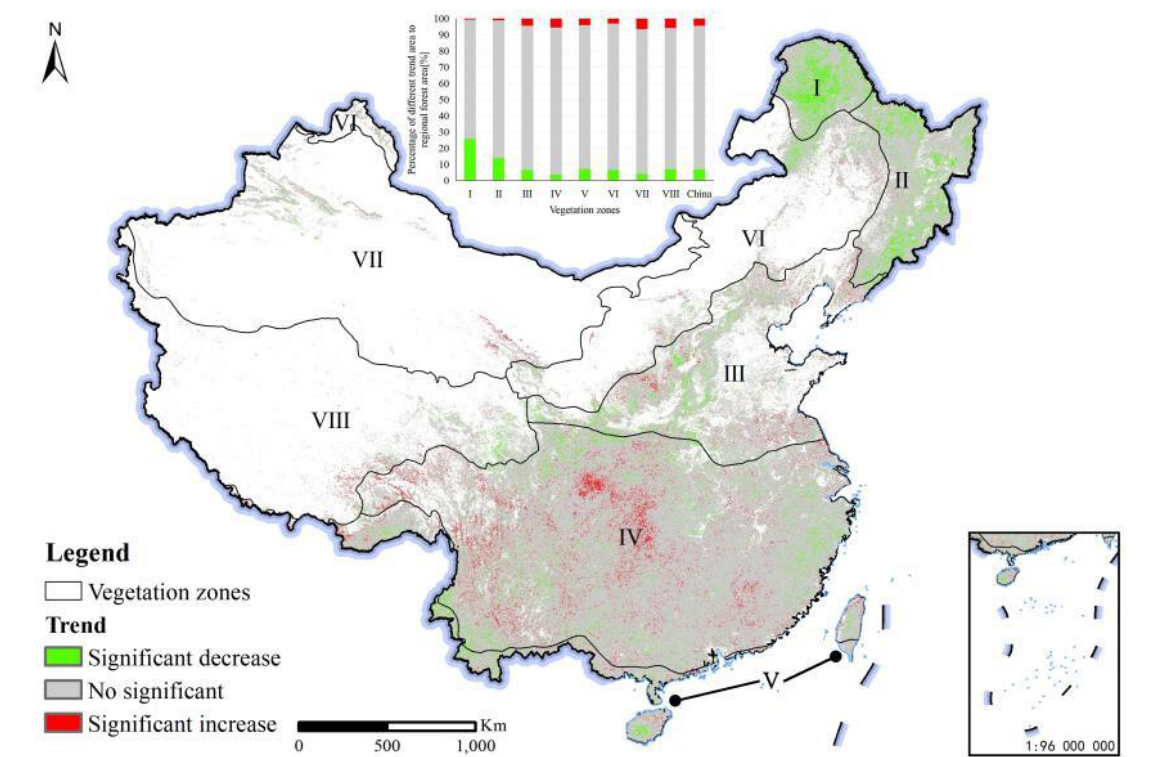
Figure 6. Spatial distribution of the results of the Mann–Kendall time trend test for forest vulnerability to fire disturbance (PBL rel ).